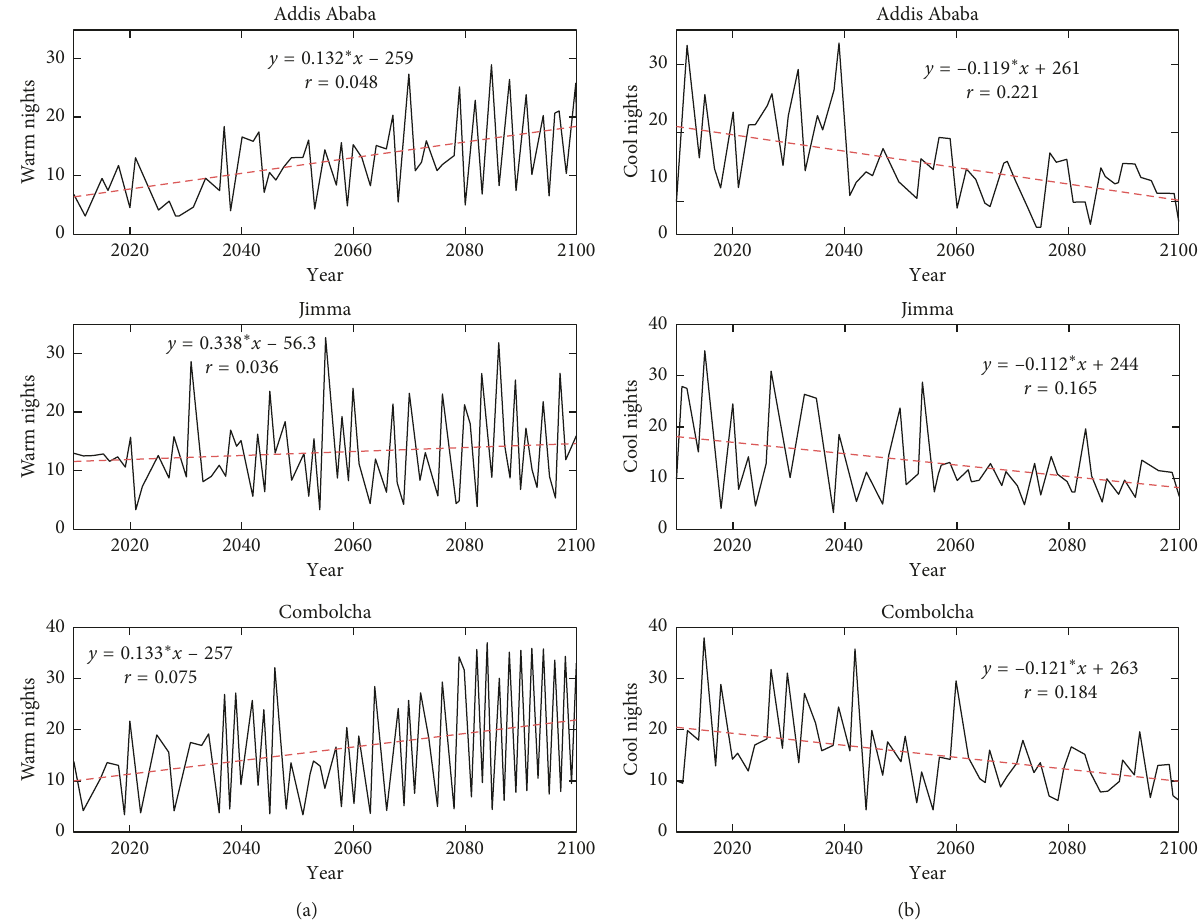
Figure 13: Projected ensemble trends of temperature extremes over Ethiopia’s warm nights (a) and cold nights